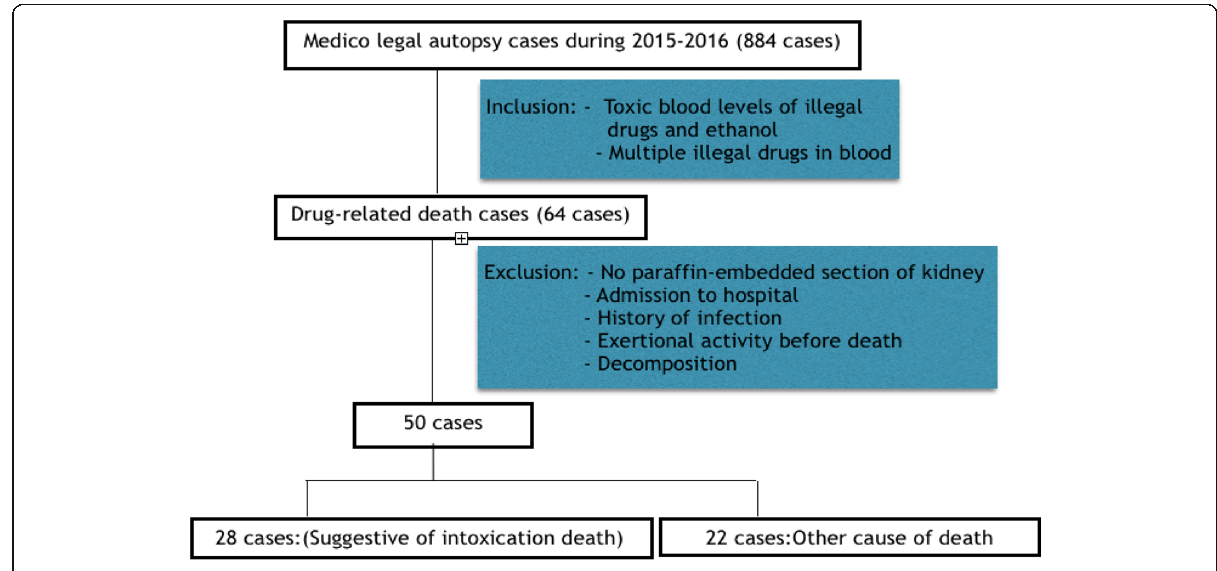
Fig. 1 The flow chart of this